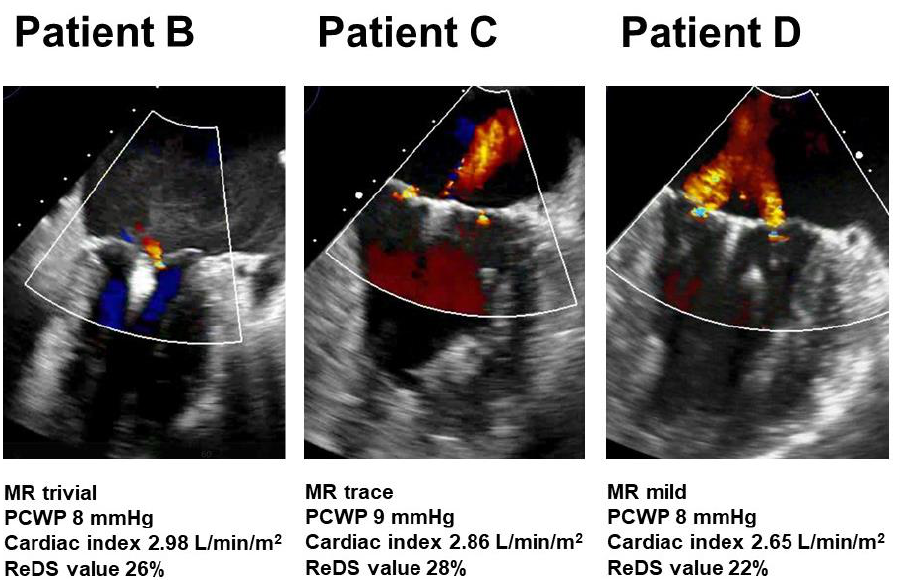
Figure 3. Transesophageal echocardiography following MitraClip procedure in patients B–D. MR, mitral regurgitation; PCWP, pulmonary capillary wedge pressure; ReDS, remote dielectric sensing.